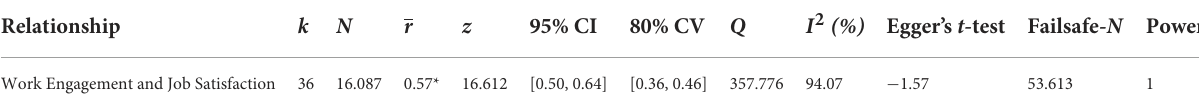
TABLE 2 Meta-analytic results. Relationship k N r z 95% CI 80% CV